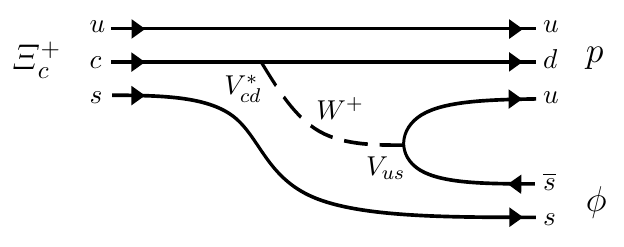
Figure 1 . Tree quark diagram for the (cid:4) +